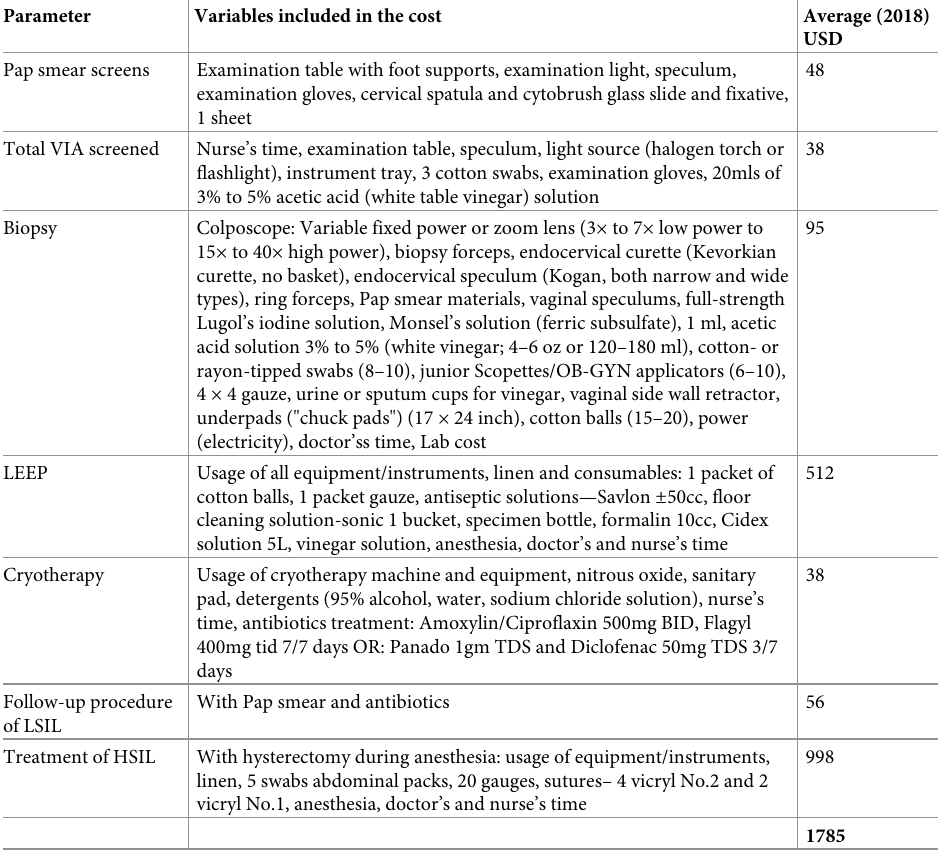
Table 2. Costs for prevention, management and treatment for cervical lesions expressed in 2018 USD average exchange rate of $1 =